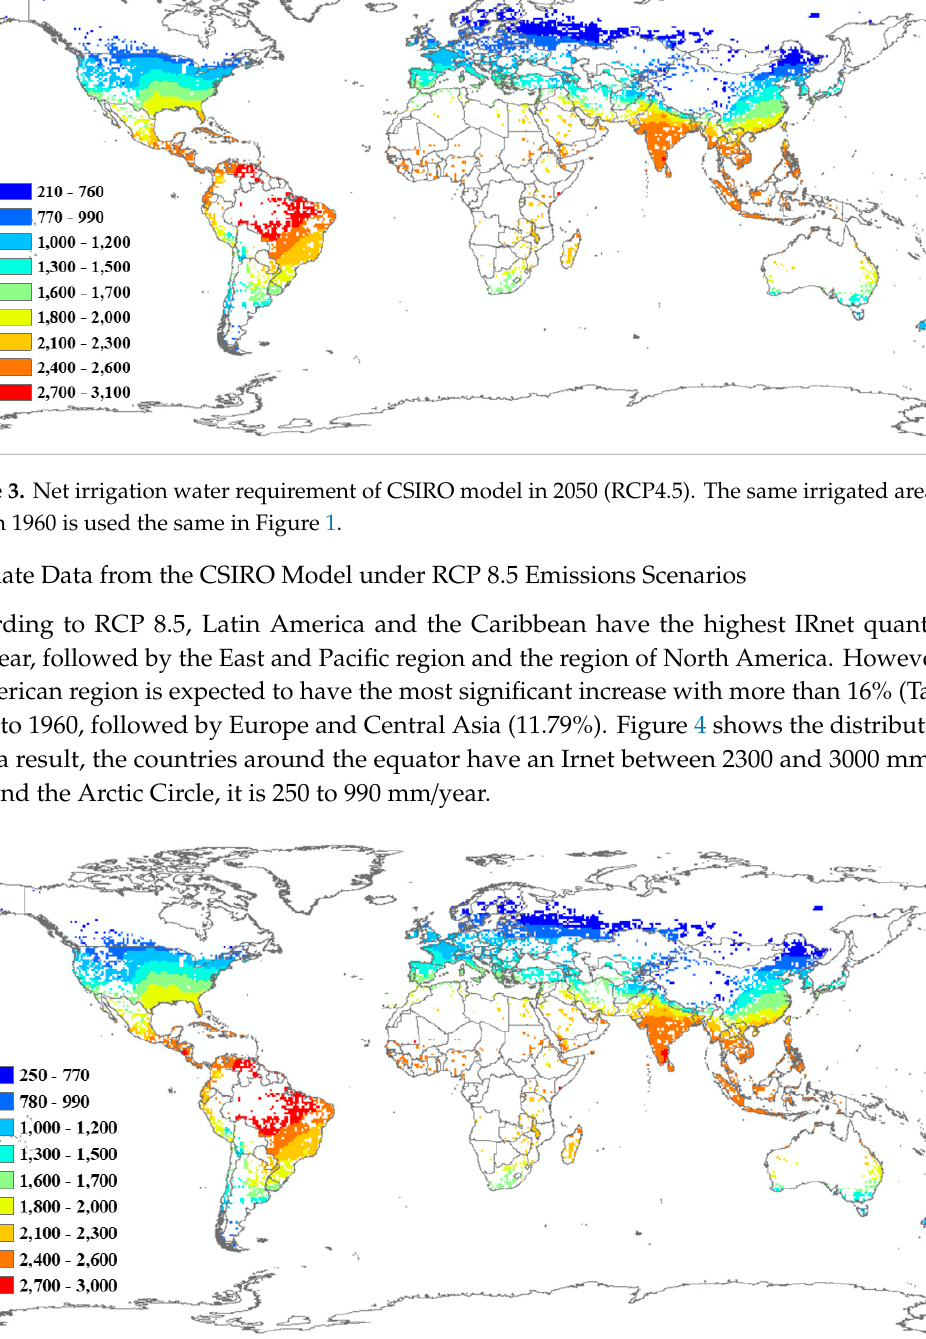
Figure 5. Net irrigation water requirement of ECHAM model in 2050 (RCP4.5). The same irrigated area than 1960 is used the same in Figure 1. 3.2.4. Climate Data from the ECHAM Model under RCP 8.5 Emissions Scenarios Figure 6 shows that the amount of IRnet varies between 260 and 2800 mm/year. The small quantities are mostly observed around the poles. However, between Cancer and Capricorn latitude, the values are quite high between 2300 and 2800 mm/yr. Compared with 1960, the region of the